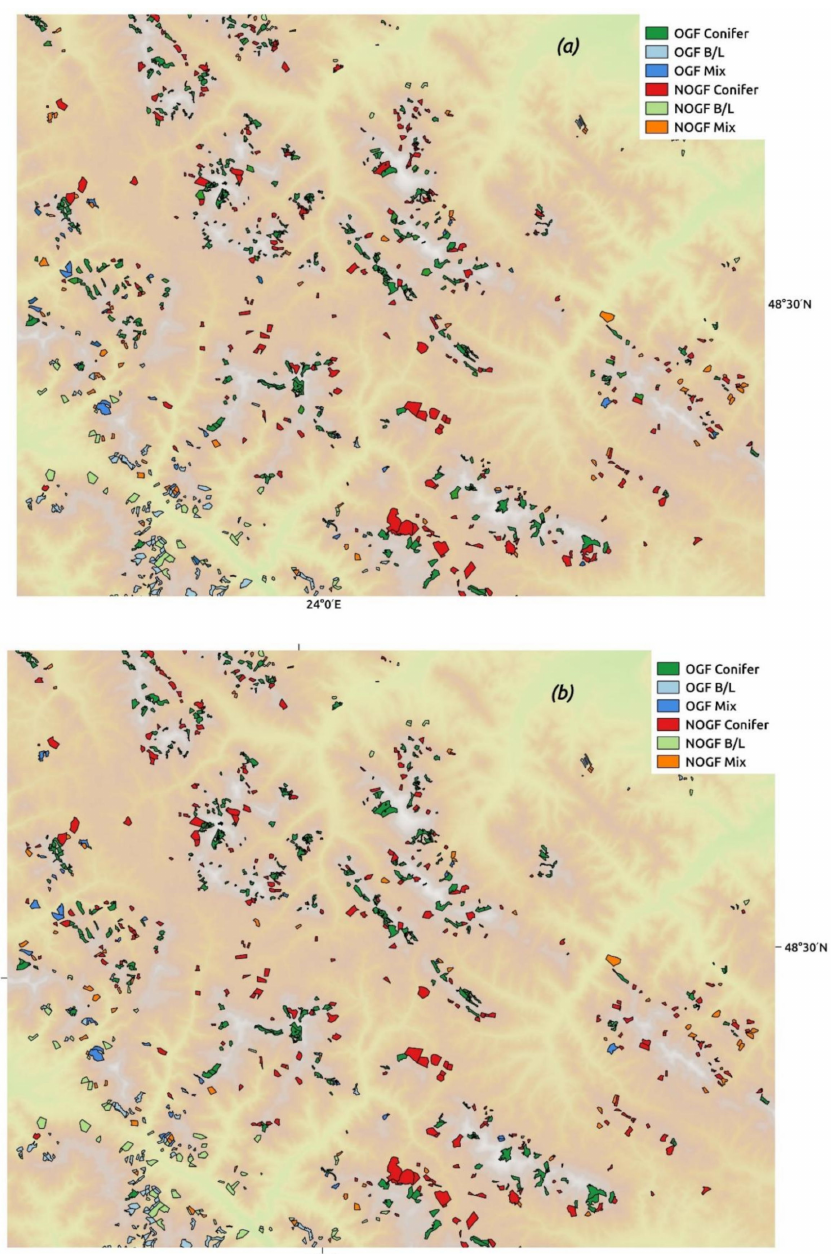
Figure 4. Map of Old-Growth Forest and Non-Old-Growth Forest based on ( a ) the Random Forest classifier using all features for combined summer and autumn images ( b ) the WWF ground